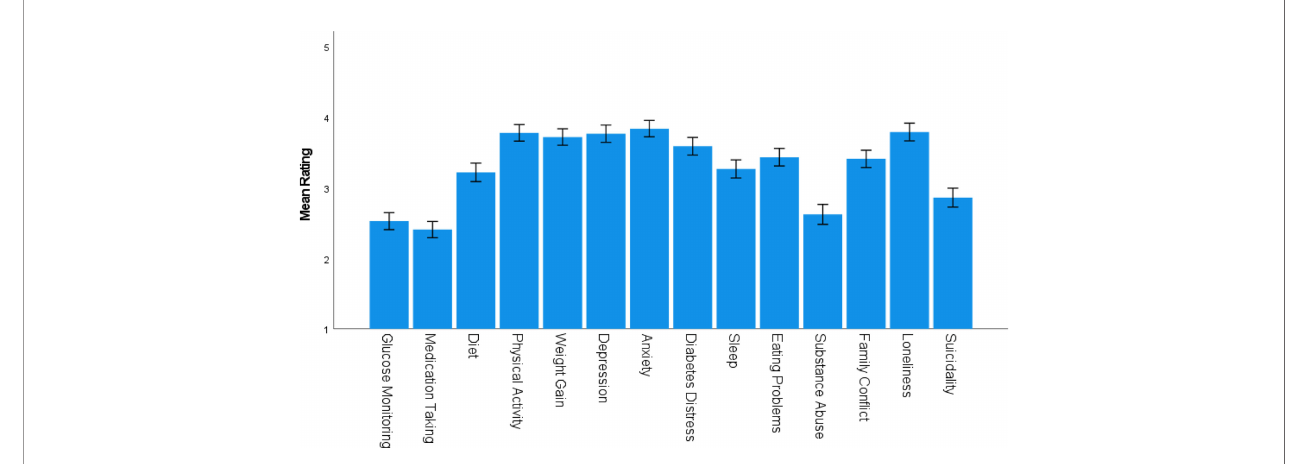
FIGURE 1 | Mean ( ± SEM) Concerns Regarding PWD. PWD, People with diabetes, i.e., people with whom the respondent